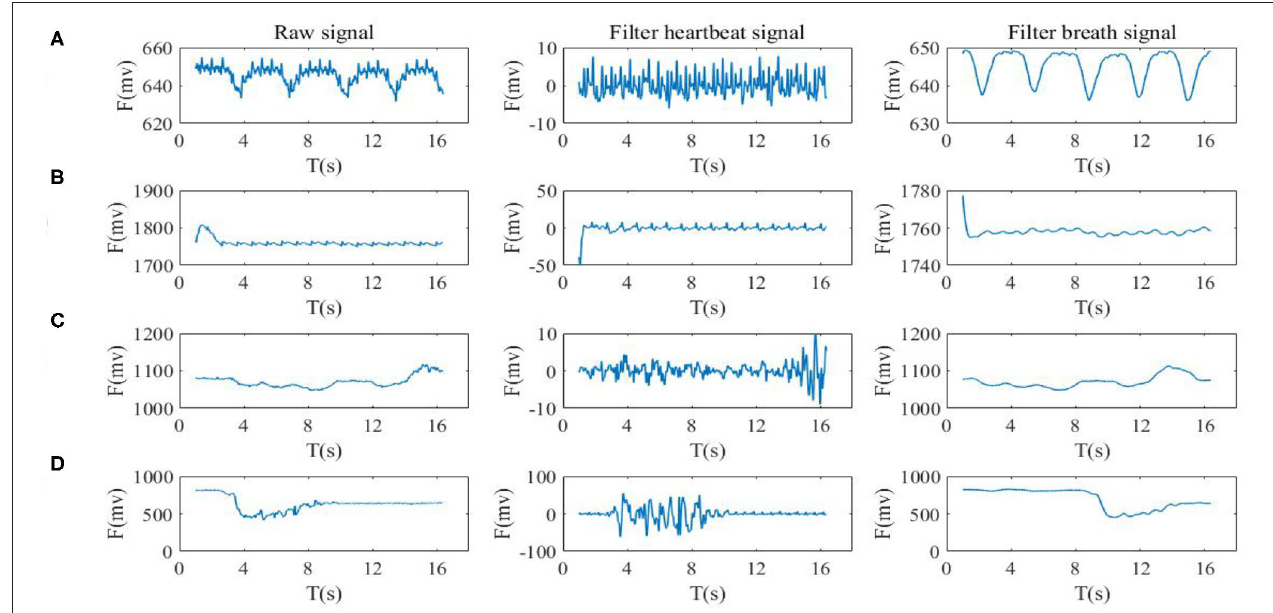
FIGURE 6 | Signal separation of BCG. The left side is the original signal of the sensor, and the right side is a pre-treated BCG signal according to the band filter (A) static state waveform, (B) the holding breath, (C) slow respiration, and (D) the movement